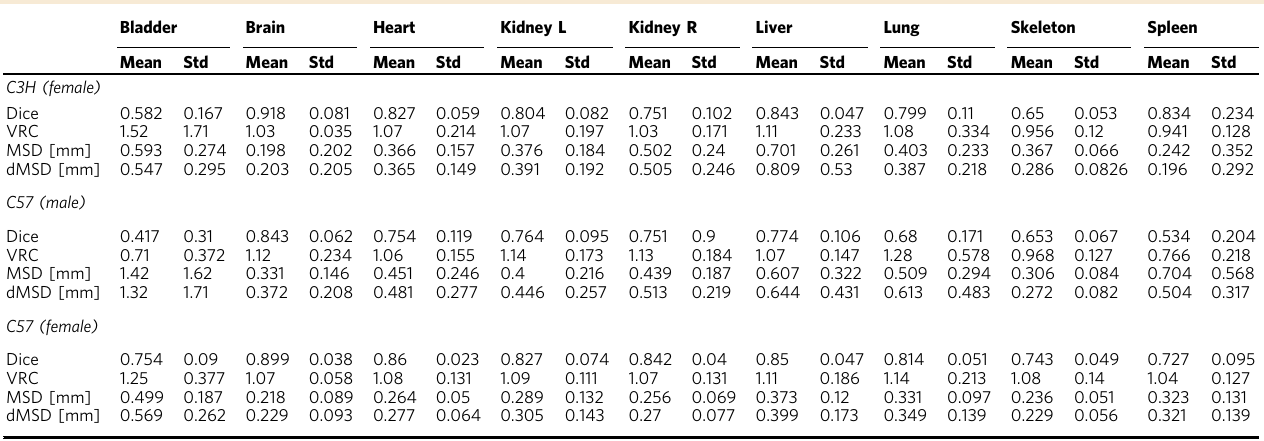
Table 1 Dice coef fi cient, VRC, MSD, and dMSD